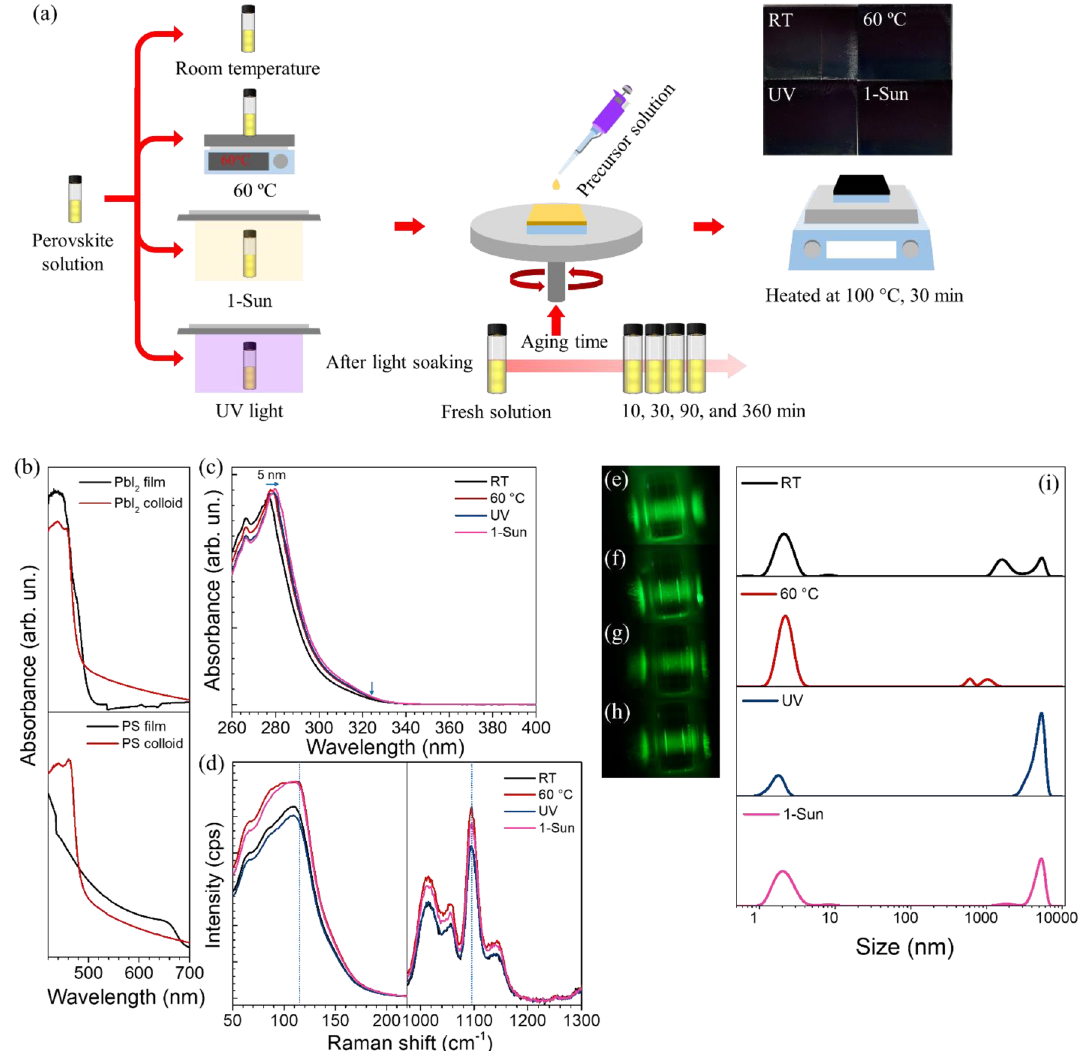
Figure 2. ( a ) Energy stimuli applied to perovskite solutions and film photographs. ( b ) UV–Vis spectra of thin films (black) and colloids (red) for PbI 2 (top) and perovskite (bottom). ( c ) UV–Vis spectra of perovskite precursors with different energy stimuli applied to perovskite solutions. ( d ) Raman spectra of different perovskite thin films. Tyndall effect photographs of ( e ) RT, ( f ) 60 °C, ( g ) UV, and ( h ) 1-Sun samples. ( i ) Size distribution by dynamic light